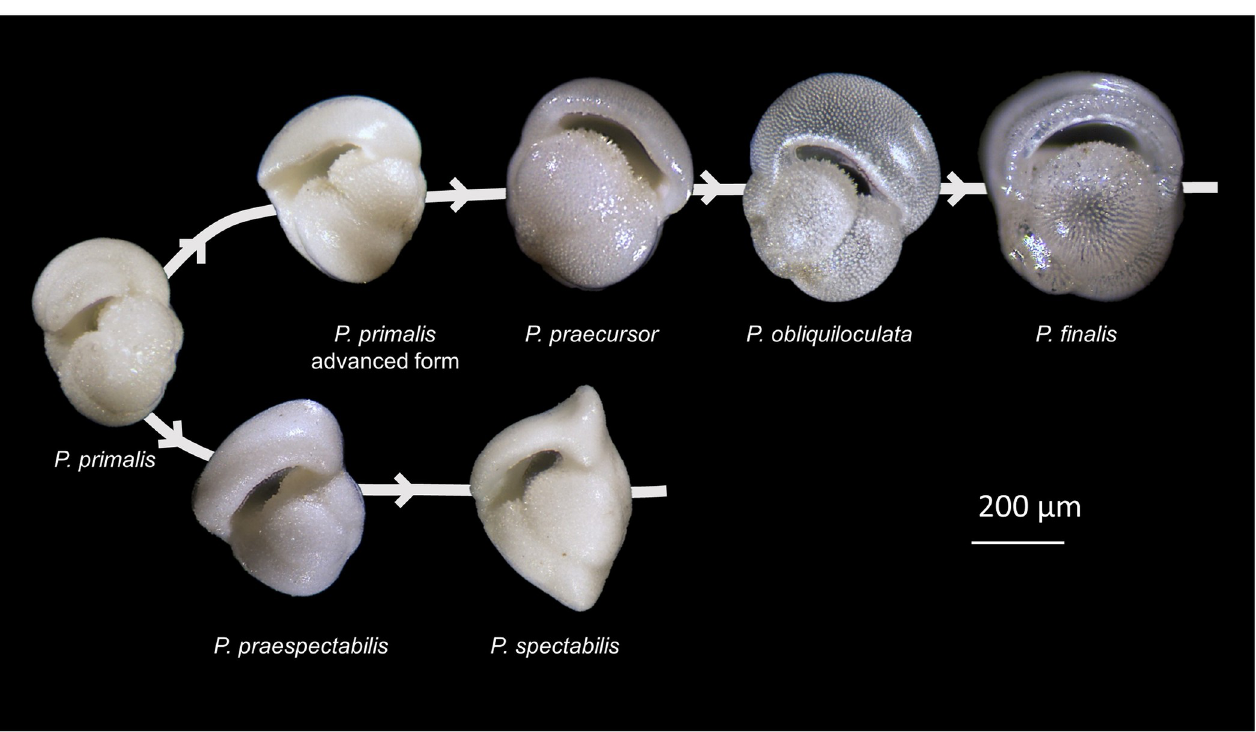
Fig 2. Examples of fossil Pulleniatina morphospecies arranged in two lineages. ‘ P . primalis ’ from upper Miocene Biozone M13b at level of first appearance approximately 6.4 Ma showing transition from Neogloboquadrina acostaensis , Sample U1488A–21H–4, 79–81 cm, Eauripik Rise, western tropical Pacific Ocean. ‘ P . primalis advanced form’ from Pliocene Biozone PL2 (lower part) approximately 4.2 Ma, Sample U1488A–12H–CC, Eauripik Rise, western tropical Pacific Ocean. ‘ P . praecursor ’ from Pliocene Biozone PL2 (lower part) approximately 4.2 Ma, Sample 873B–3H–3, 10–12 cm, Wodejebato Guyot, western tropical Pacific Ocean. ‘ P . obliquiloculata ’ and ‘ P . finalis ’ from Pleistocene Biozone PT1 approximately 0.8 Ma, Sample U1483A–11H–2, 50–52 cm, off northwest Australian margin, eastern tropical Indian Ocean. ‘ P . praespectabilis ’ from Pliocene Biozone PL1 approximately 4.8 Ma, Sample 873B–3H–5, 10–12 cm, Wodejebato Guyot, western tropical Pacific Ocean. ‘ P . spectabilis ’ from Pliocene Biozone PL2 (lower part) approximately 4.2 Ma, Sample 873B–3H–3, 10– 12 cm, Wodejebato Guyot, western tropical Pacific Ocean. Photographs obtained with a z-stacking light microscope.